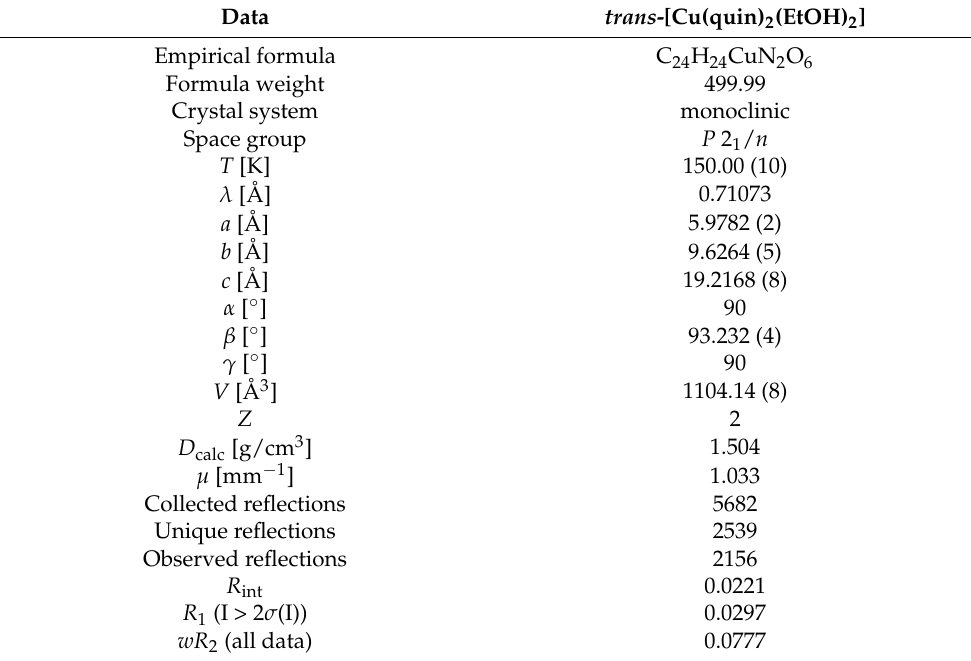
Table 1. Crystallographic data for trans -[Cu(quin) 2 (EtOH) 2 ] ( 1